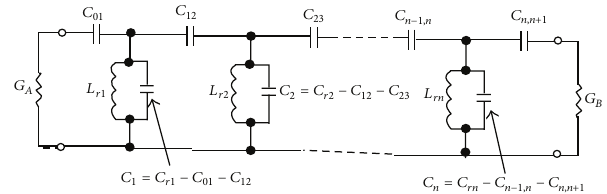
Figure 4: Circuit model of a band-pass filter with electric coupling between the transmission lines used in its structure.